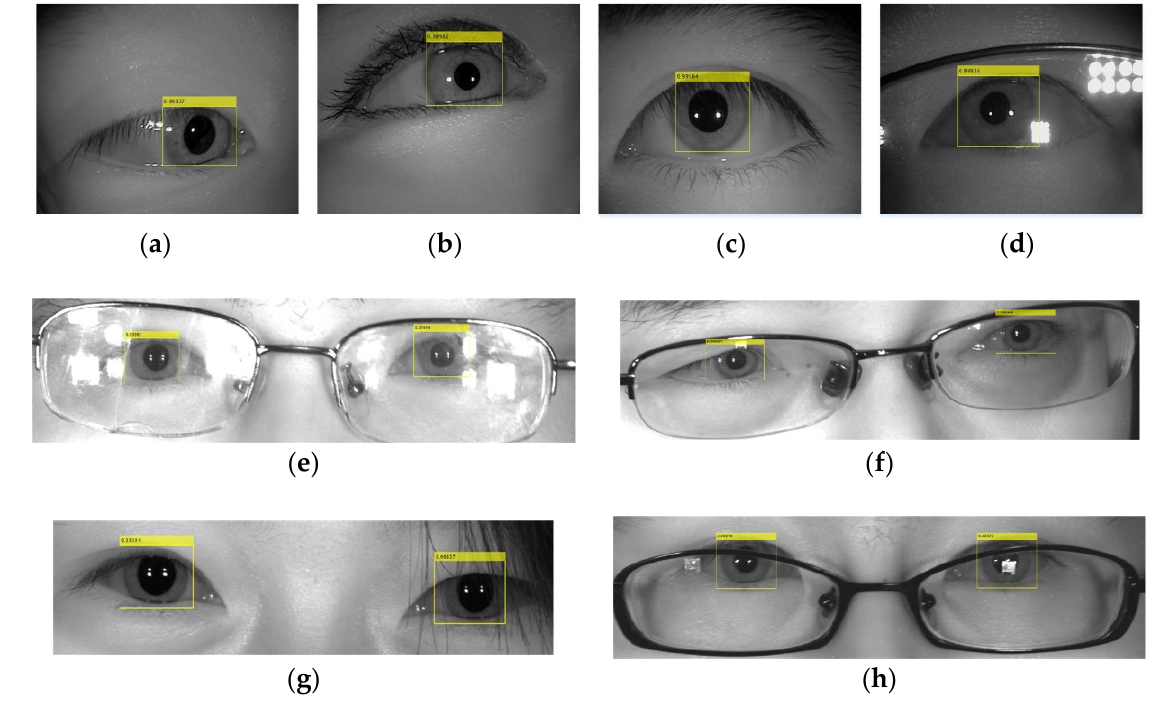
Figure 6. Some results of typical iris images obtained in non-cooperative environments. ( a ) Off-angle iris; ( b ) iris obscured by eyelids; ( c ) iris interfered with by eyelashes; ( d , e ) iris with specular reflection; ( f ) off-angle iris at a long distance; ( g ) iris obstruction due to hair; ( h ) glasses obstructing the iris [22]. Table 1. mAP of two detection networks under different IoU.